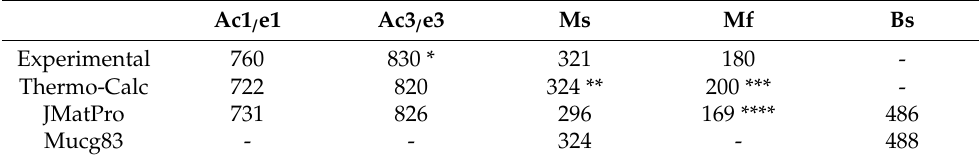
Table 2. Measured and predicted characteristic temperatures of AR casting. Ac1 / e1 Ac3 / e3 Ms Mf Bs Experimental 760 830 * 321 722